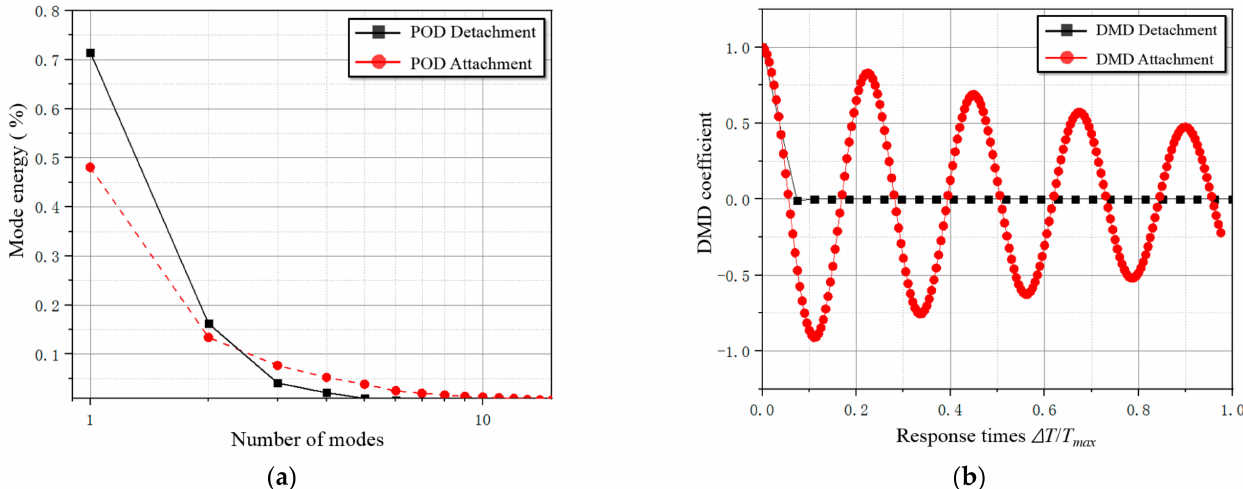
Figure 10. The POD results and DMD results of jet attachment and detachment conditions. ( a ) The modal energy distribution of the POD under attachment and detachment conditions; ( b ) the modal coefficient curve of the DMD under attachment and detachment